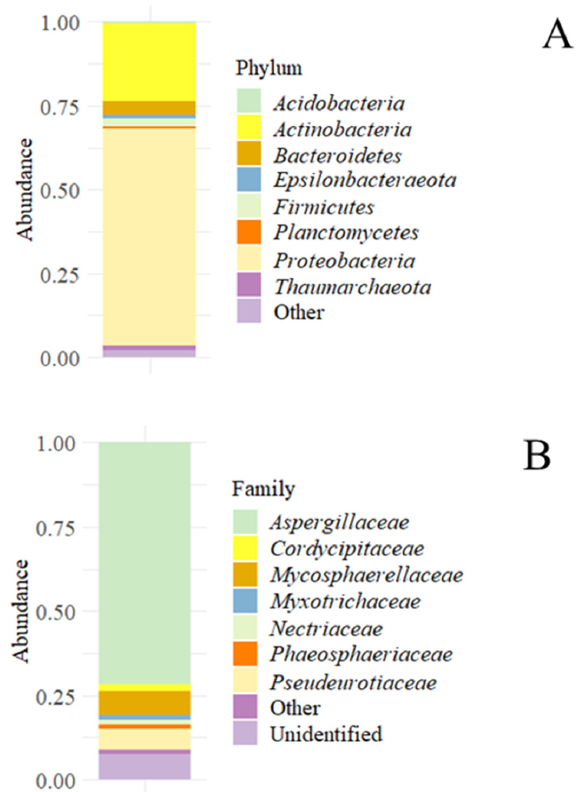
Figure 1. Accumulated microbial abundances in the sediment sample. ( A ) Accumulated bacterial and archaeal abundances at the phylum level. ( B ) Accumulated fungal abundance at the family level. Table 3. Isolated bacterial strains in the sediment. Culture media and temperature of